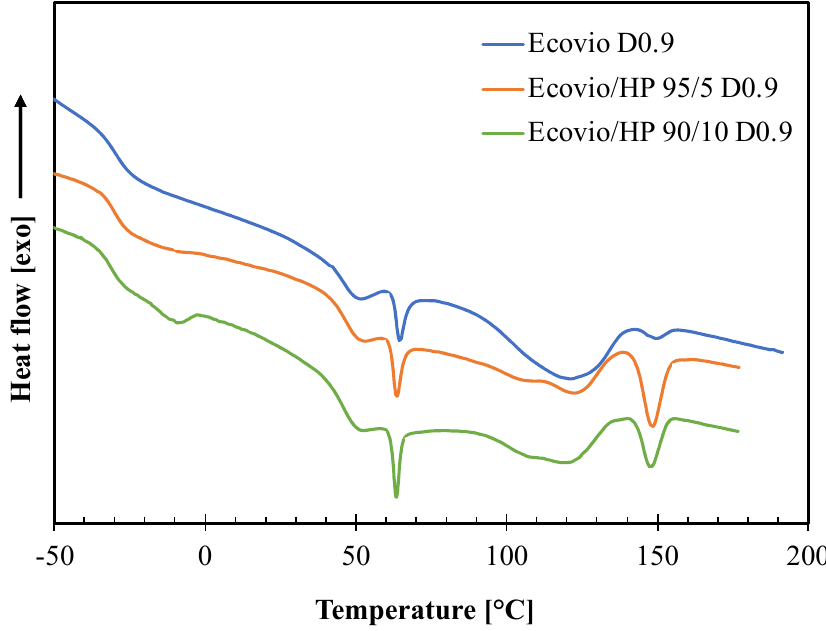
Figure 8. DSC thermograms of active films produced at different HP loadings (0, 5, 10 wt%) and draw − up speed equal to 0.9 m/min (D0.9). Table 6. DSC results of active films produced at different HP loadings (0, 5, 10 wt%) and draw ‐ up speed equal to 0.9 m/min (D0.9).